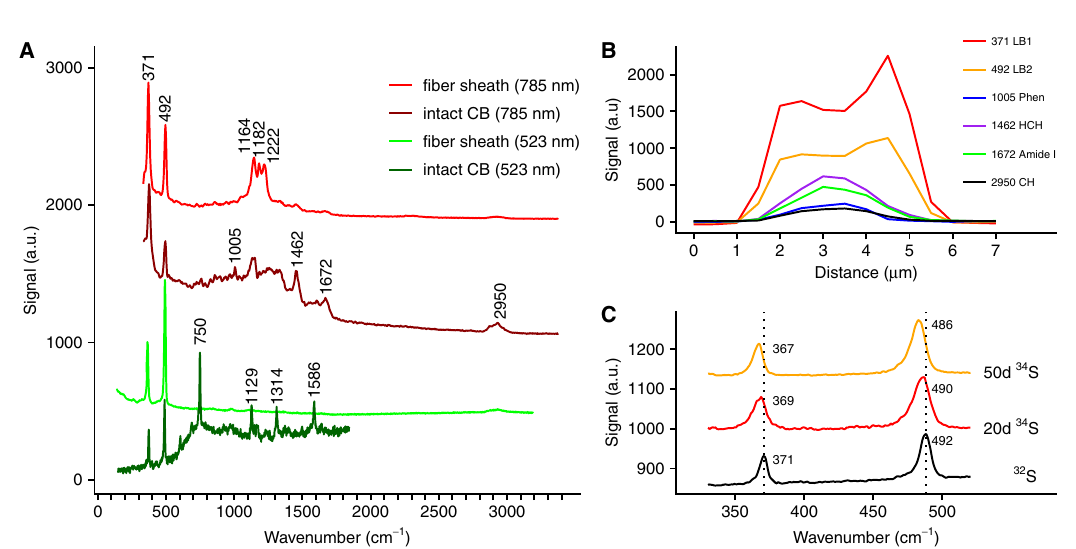
Fig. 2 Raman spectra of intact cable bacteria and fi ber sheaths indicating a sulfur-ligated metal group in the fi ber sheath. A Raman spectra collected with green (523 nm) and NIR (785 nm) lasers. The low-frequency bands at 371 and 492 cm − 1 suggesting the presence of a metal group, and are present in all spectra. The dark green spectrum is from intact, living cable bacteria (CB) in a gradient slide, while the dark red spectrum is recorded on intact, dried cable bacterium fi laments. The light green and light red spectra are from dried fi ber sheaths. B Variation of the Raman signal (NIR laser) in a transversal section across an intact, dried cable bacterium fi lament, which was ca. 3 μ m wide. The most prominent bands are shown: the two low-frequency bands (371 LB1, 492 LB2), phenylalanine ring-breathing (1005 Phen), CH 2 -bending (1462 HCH), the protein Amide I band (1672 Amide I) and CH-stretching (2950 CH). C Average Raman spectra (green laser) and peak shifts resulting from 34 S labeling of intact, dried cable bacterium fi laments. The two low-frequency bands are shown after 20 and 50 days of incubation and compared to the unlabeled control